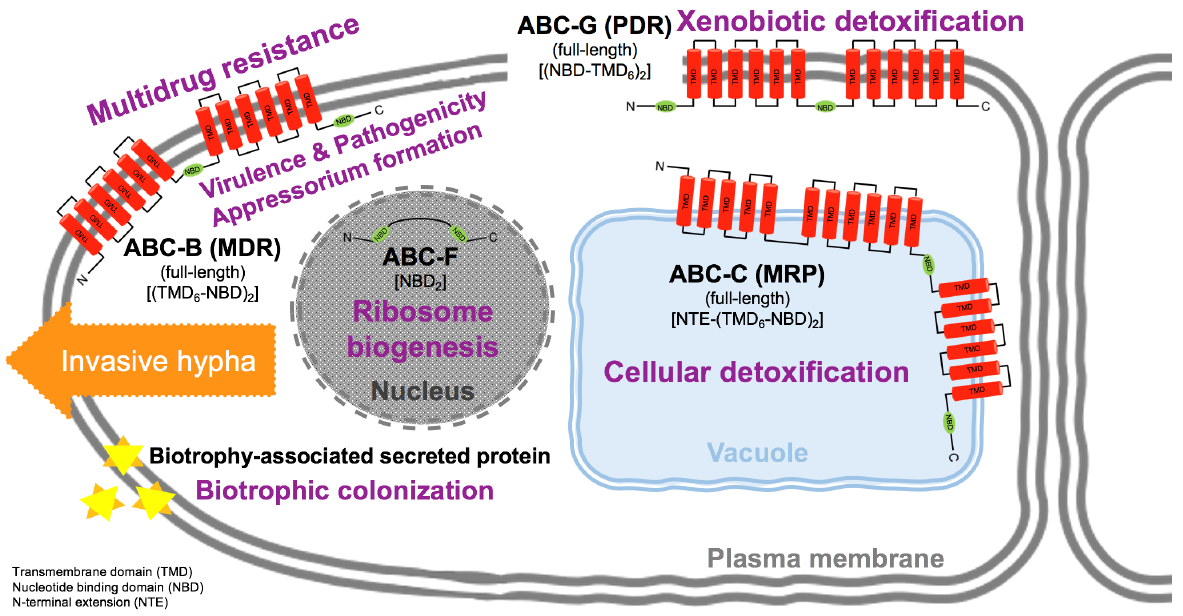
Figure 2. Schematic representation of predicted localization of the ABC transporters and the biotro- phy-associated secreted (BAS) protein in S. mycoparasitica .